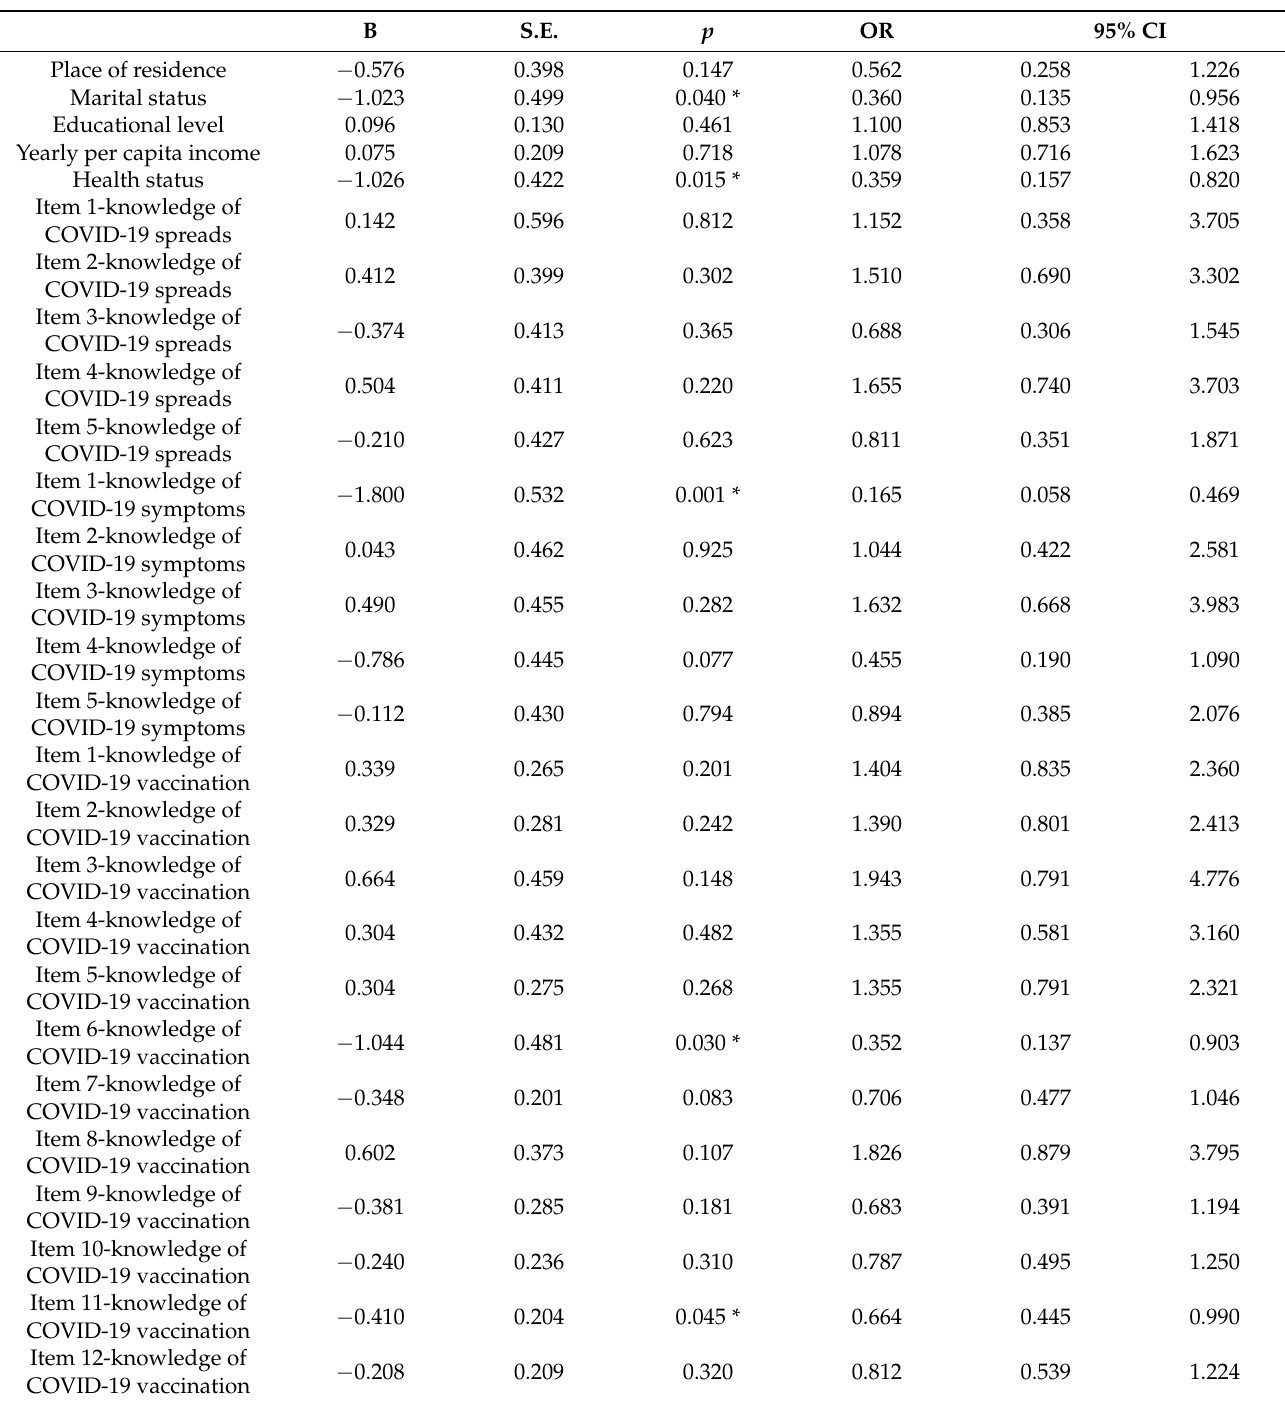
Table 5. Logistic regression analysis of vaccinated attitudes of willingness and hesitation